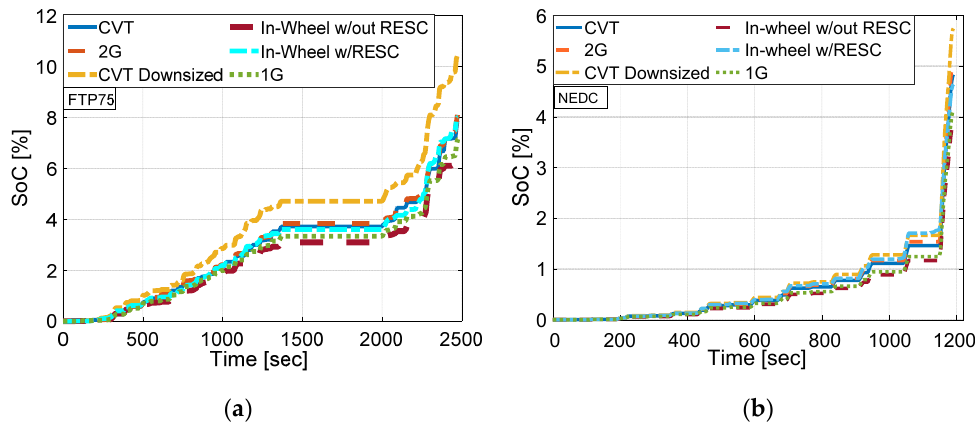
Figure 12. Comparison of the consumed hydrogen: ( a ) FTP75 drive cycle; ( b ) NEDC drive cycle.